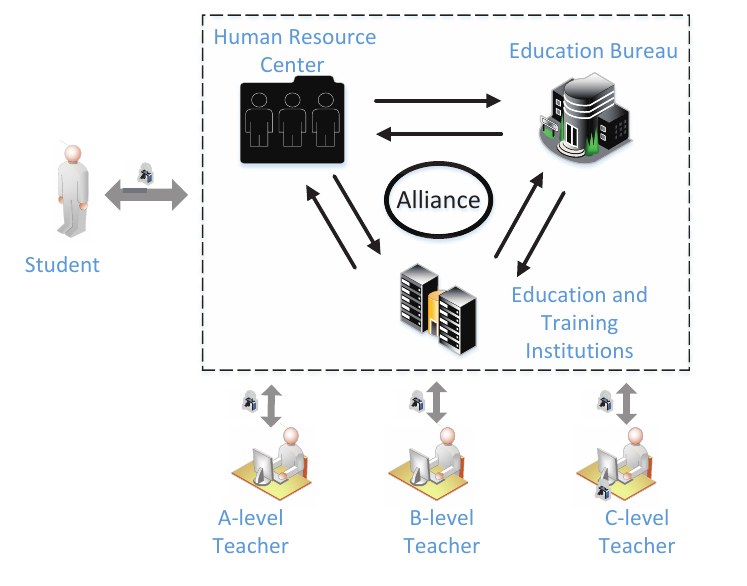
Figure 4. System